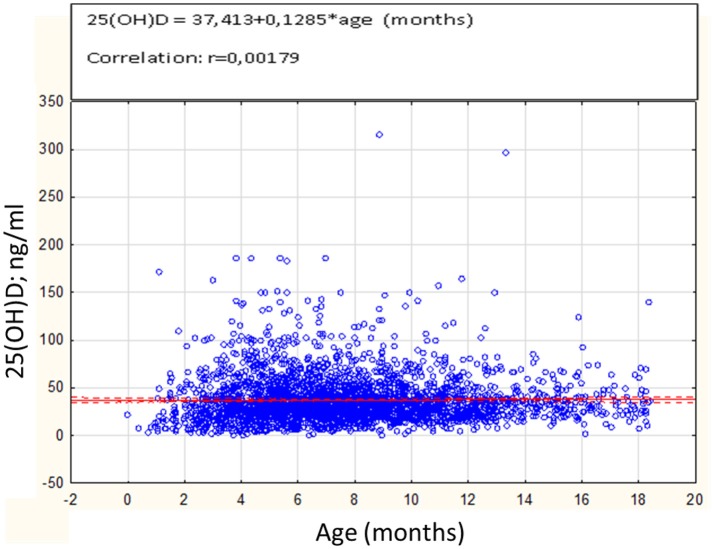
Correlation between 25(OH)D concentrations (ng/ml) and age in months (n = 3163).